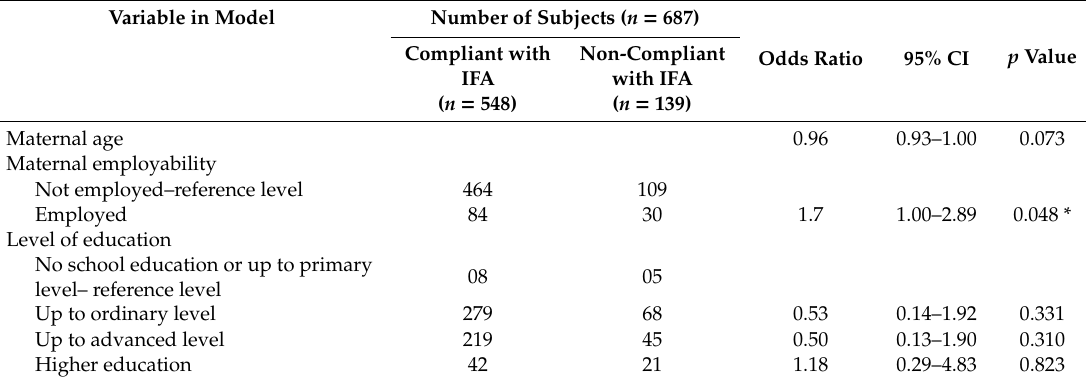
Table 3. Multivariate analysis for maternal compliance with recommended IFA